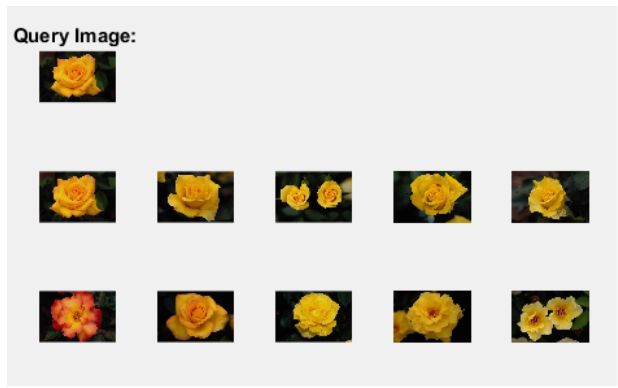
Figure 14. Retrieved top 10 images by proposed method from Corel-1K dataset